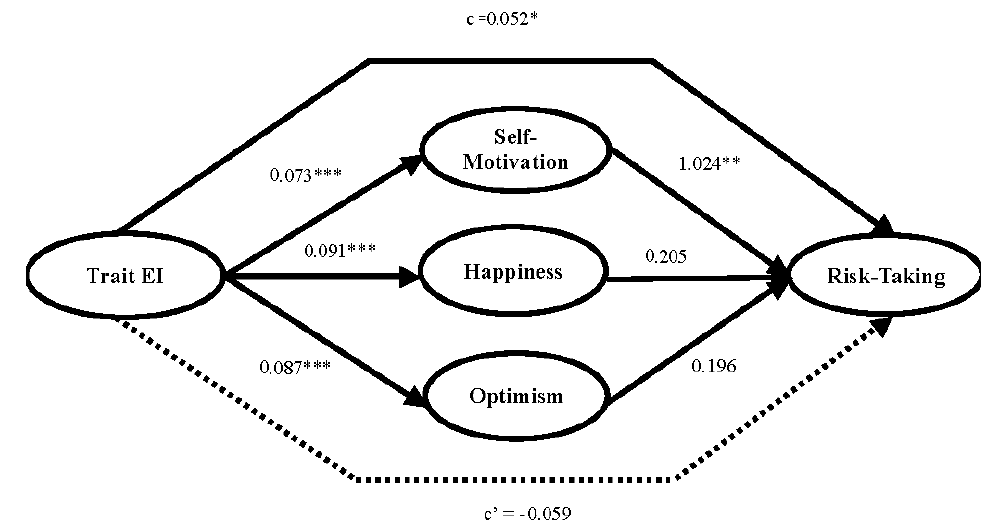
Figure 1. Mediation model showing the association between trait EI and risk taking through self-motivation, happiness and optimism. NOTE: Path values represent OLS unstandardized regression coefficients. The (c') value represents the direct effect, from bootstrapping analysis, of the trait EI on risk taking after the mediators are included. The (c) value represents the effect of the trait EI on risk taking prior to the inclusion of the mediating variables. * p < 0.05; ** p < 0.01; *** p < 0.001.